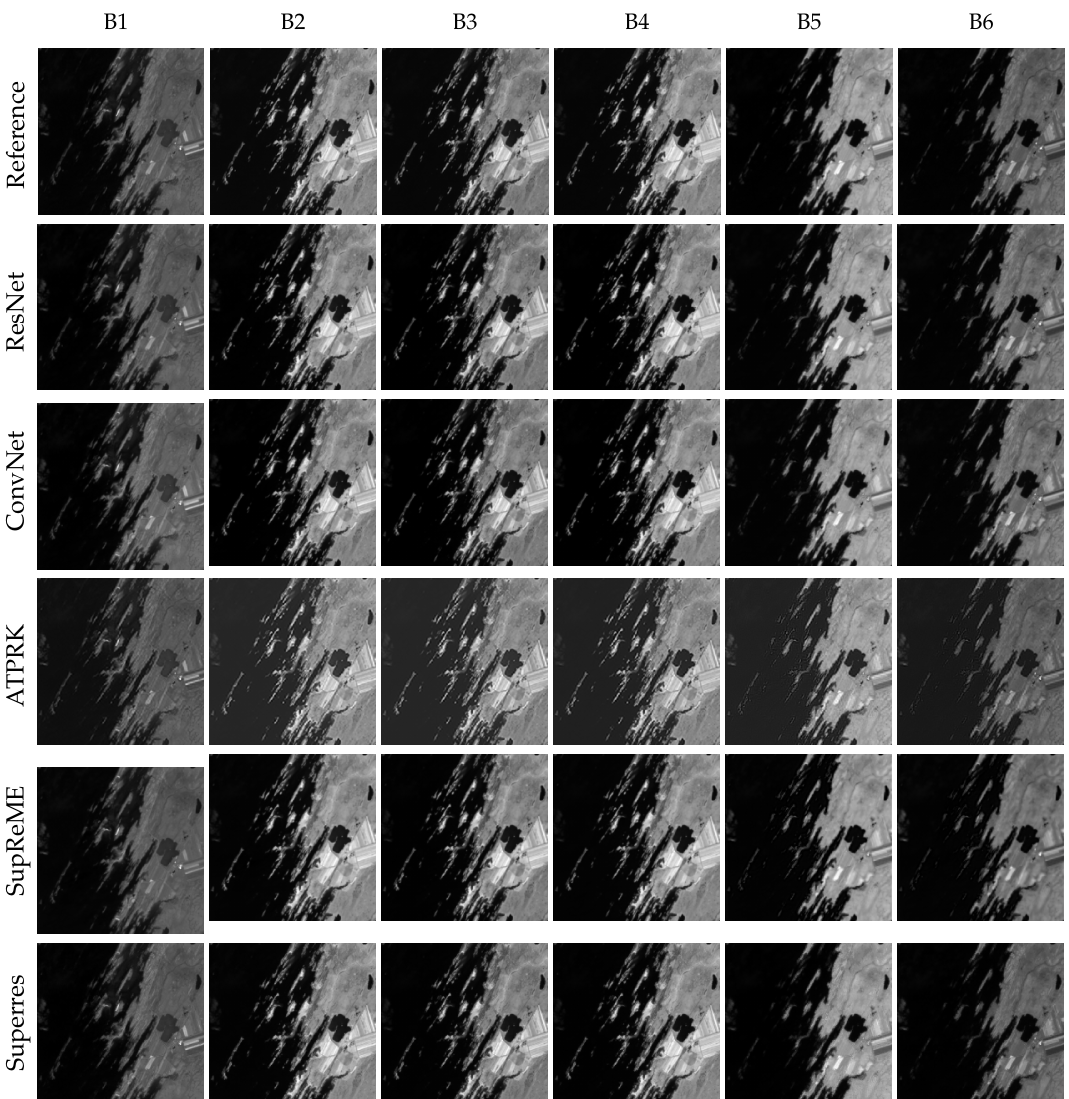
Figure 10. Visual comparison of all methods and all bands for the Coastal-A